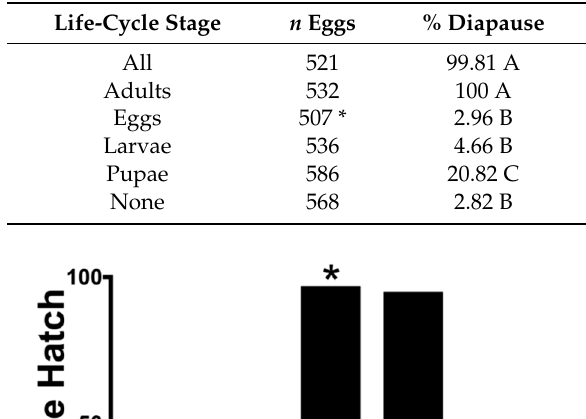
Table 1. Effect of a short-day photoperiod (8 L:16 D) on Aedes japonicus japonicus F 2 life stages on F 3 percent diapause. All other F 2 life-cycle stages were exposed to a long-day photoperiod (14 L:8 D). * = eggs of the F 2 generation were tested for percent diapause. Percentages followed by different letters are significantly different (Fisher’s exact test, p ≤ 0.01).